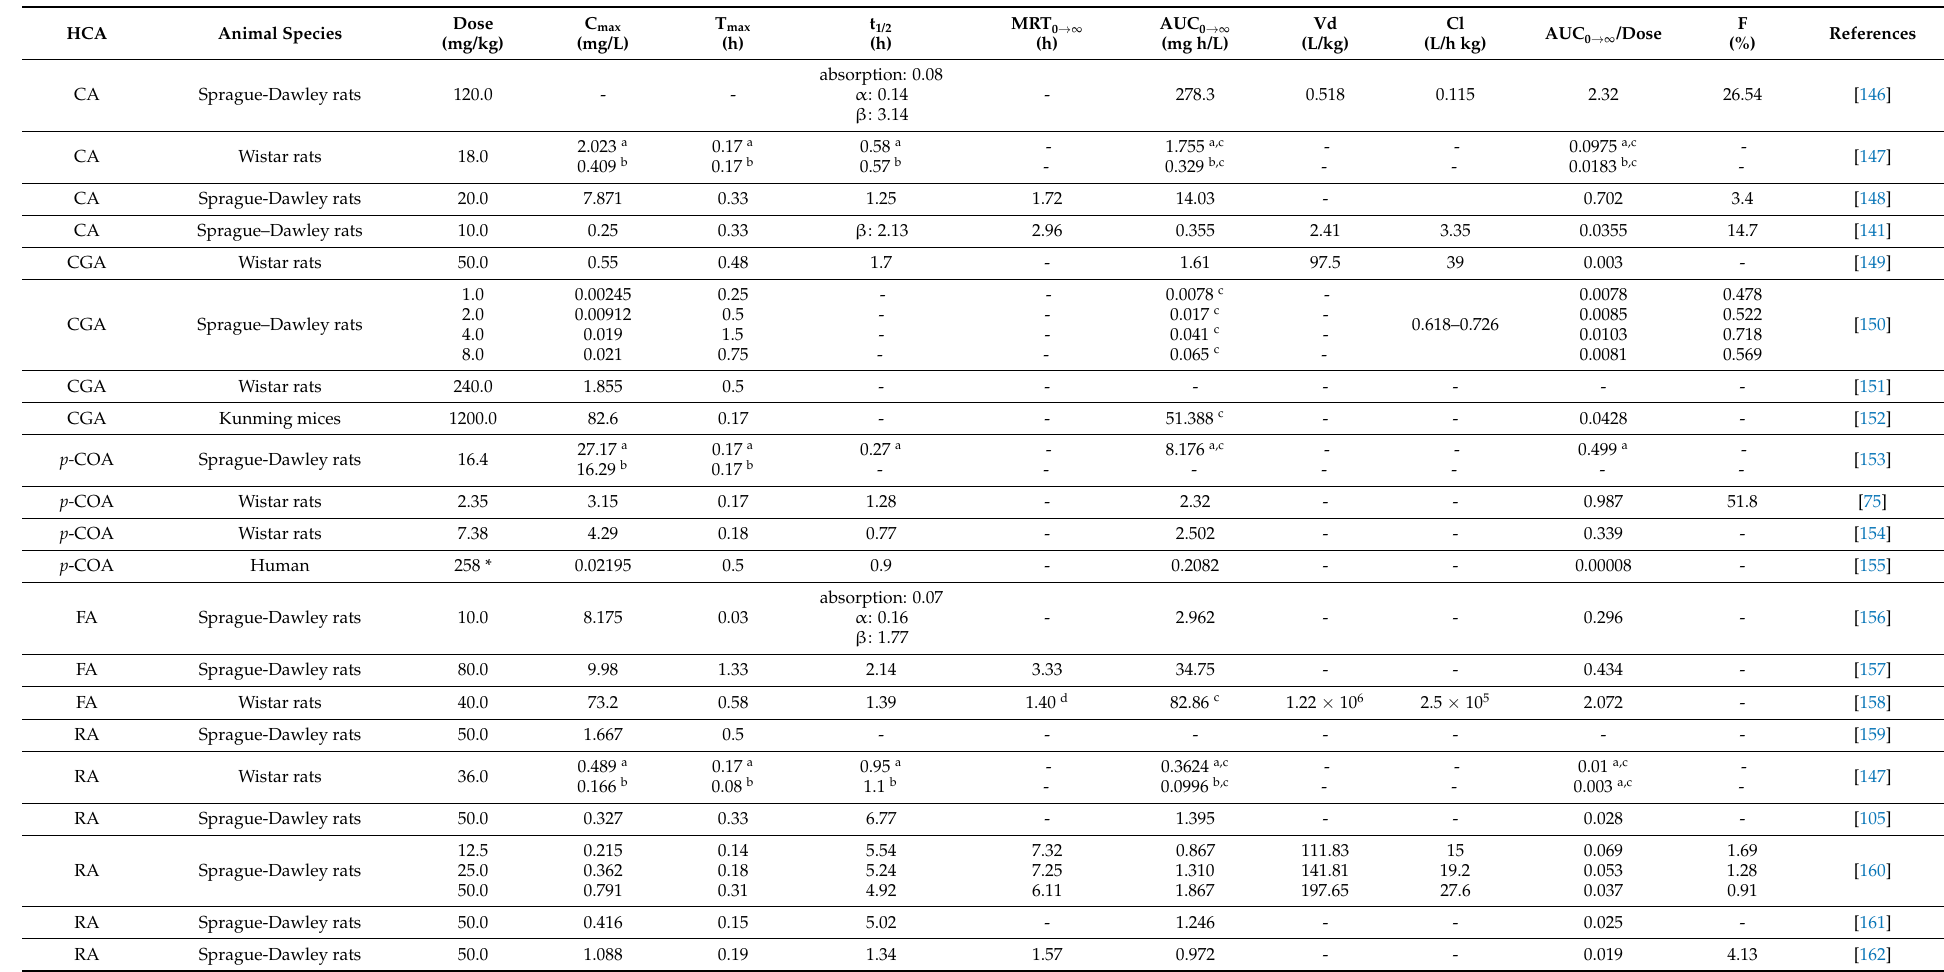
Table 2. Pharmacokinetic parameters of orally administered